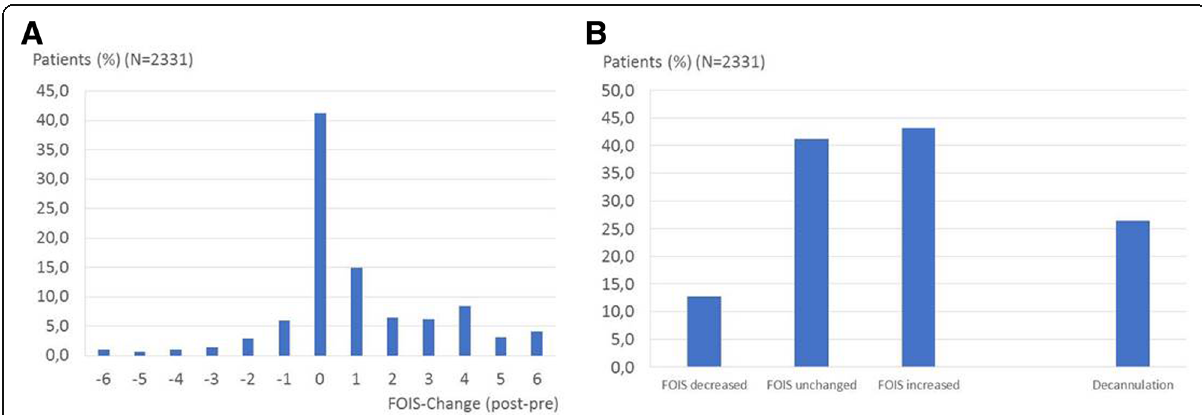
Fig. 3 Changes of dysphagia management after FEES. a : Detailed changes of FOIS score after FEES. A positive value indicates an upgrade of the FOIS score after FEES, a negative value indicates more restrictive feeding strategy. b : Summary of FOIS changes and management of tracheotomised patients with regards to